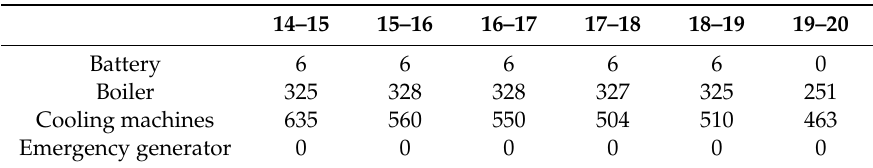
Table 10. Baselines for iteration 3.